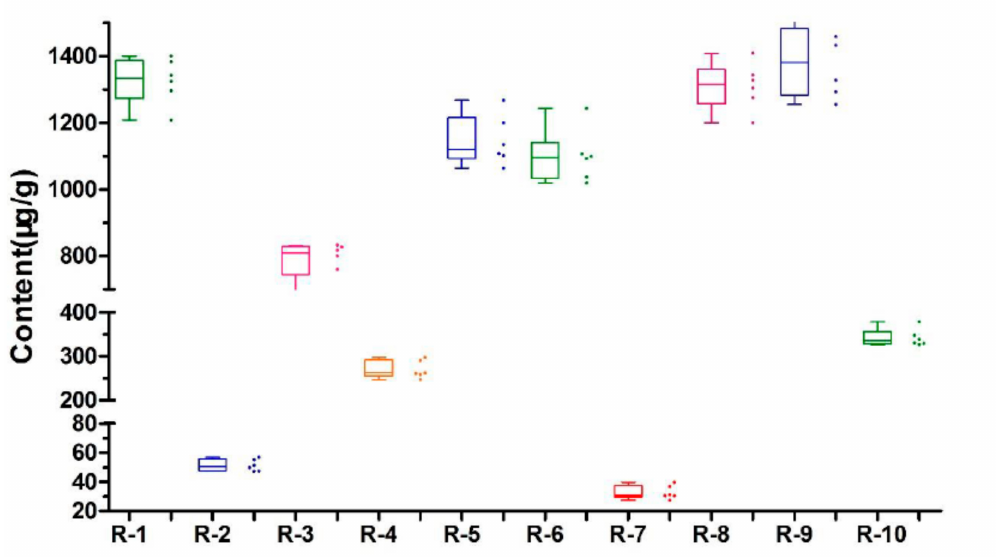
Figure 5. Boxplots of luteoloside in Lonicera japonica Thunb. from di ff erent regions. * Indicates the strands of the Chinese Pharmacopoeia (2015